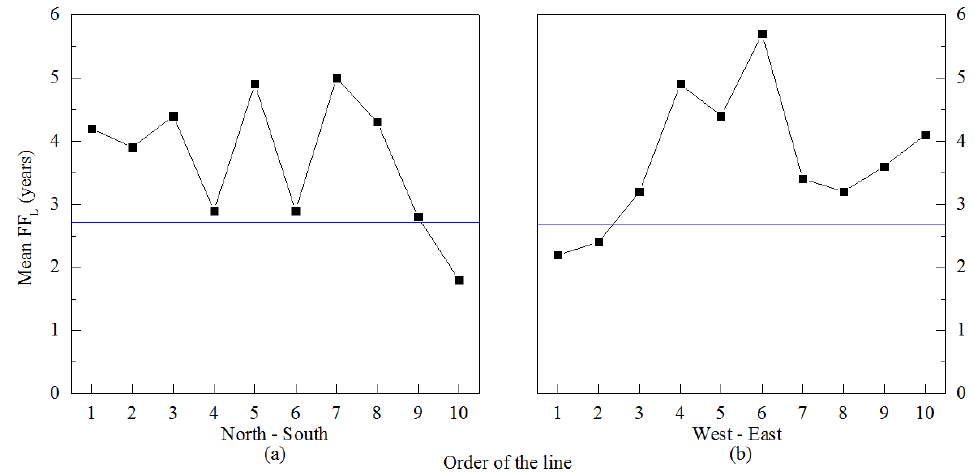
Figure 4. The Removal of Outer Lines (ROL) method of detecting edge effected regions (EER) with reduced fire frequency (RFF), using the hypothetical landscape in Figure 2a. The mean FF L is graphed for all lines, ordered from ( a ) the north (top, line 1) to the south (bottom, line 10), and ( b ) the west (left, line 1) to the east (right, line 10). The blue lines indicate the EER ROL threshold values. EERs with RFF were identified for three lines whose FF L was below the EER ROL threshold: ( a ) North-South line 10 and ( b ) West-East lines 1 and 2.